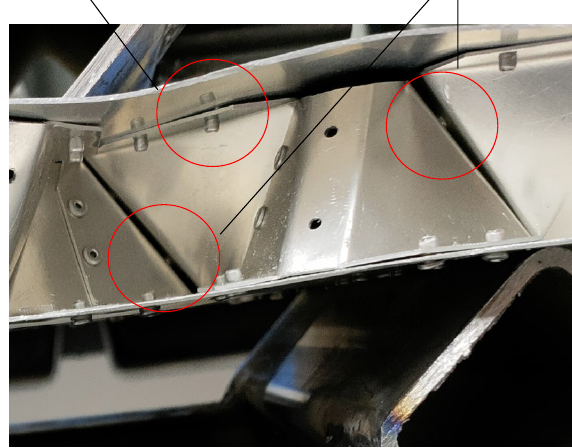
Figure 12. Partial enlargement of three-point bending test.